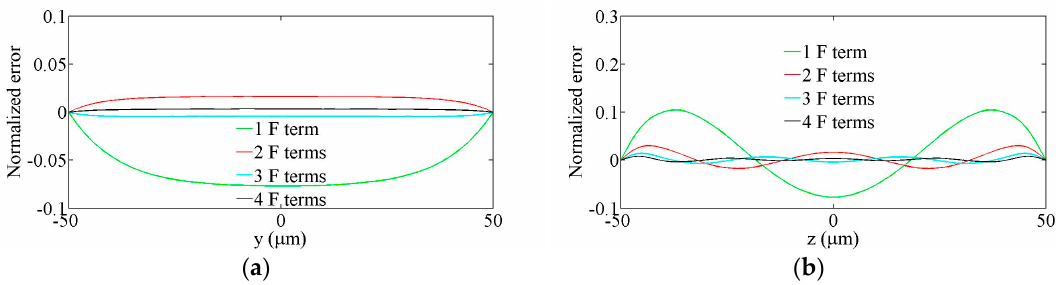
Figure 3. Normalized errors in the Q3D-calculated velocity profiles as a function of Fourier (F) terms in the Q3D model, ( a ) across the horizontal mid-line, z = 0; ( b ) across the vertical mid-line, y = 0. The accuracy of a simulation depends on the aspect ratio, (cid:2009) = ℎ/(cid:1875) , of the channel, as shown in